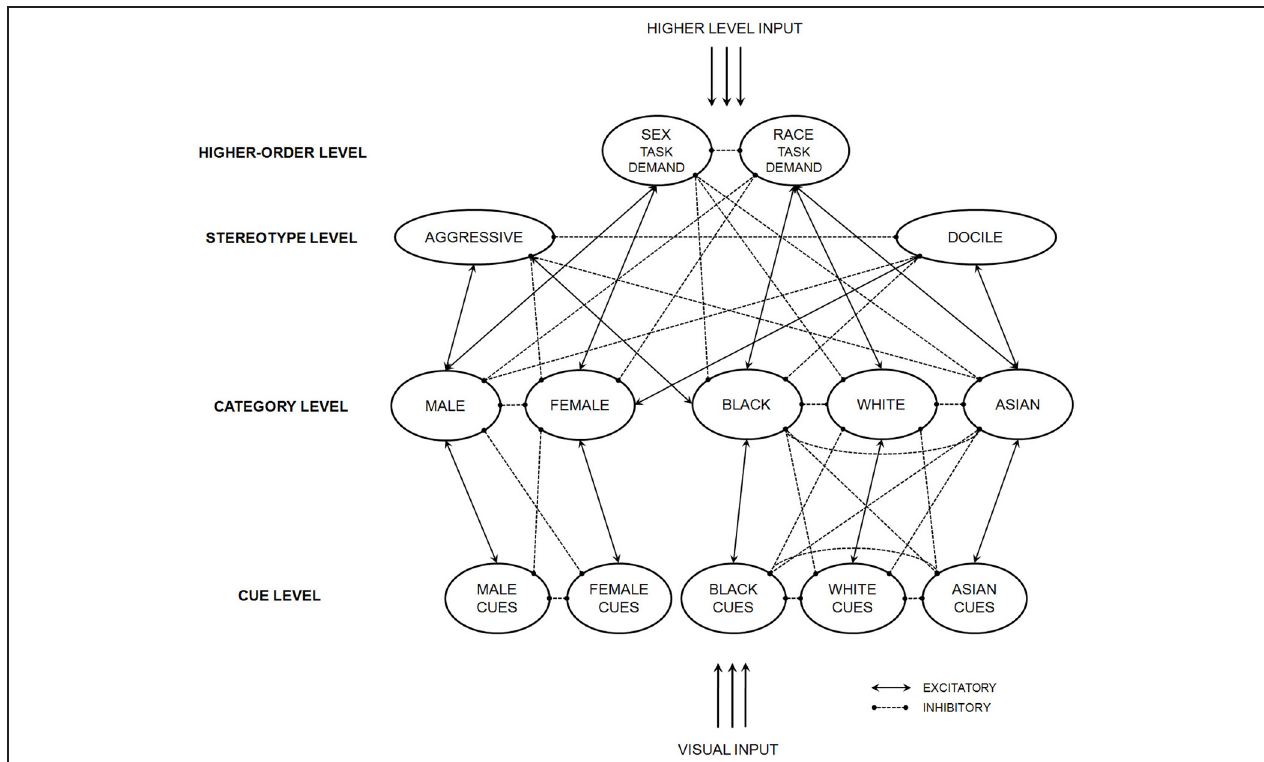
FIGURE 2 | An instantiation of the dynamic interactive model that gives rise to category interactions driven by top-down stereotypes. Adapted from Freeman and Ambady